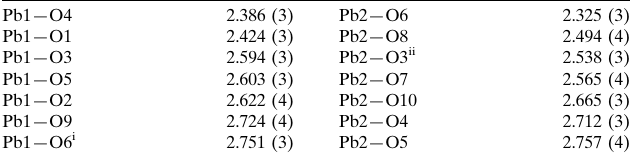
The reaction of lead(II) acetate and 3-methylbenzoic acid (MBA) in aqueous solution yielded the title polymer, [Pb(C H O ) (H O)] . The asymmetric unit contains two Pb II n 8 7 2 2 2 atoms, four MBA ligands and two water molecules. Each Pb II cation is heptacoordinated and chelated by four carboxylate O atoms from two MBA ligands. The Pb atoms are bridged through the carboxylate O atoms from another two MBA O core. The Pb—O bond ligands, leading to a central Pb 2 2 lengths are in the range 2.325 (3)–2.757 (4) A˚ . The intra- and interdimer Pb (cid:2) (cid:2) (cid:2) Pb distances are 4.2942 (3) and 4.2283 (3) A˚ , respectively, indicating little direct metal–metal interaction.